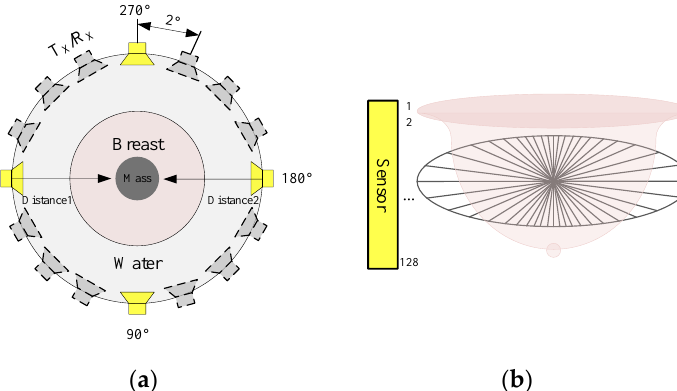
Figure 12. The ultrasound tomography test method and reconstruction slice scheme. ( a ) The circular scanning test diagram. ( b ) Breast ultrasound horizontal slice map.